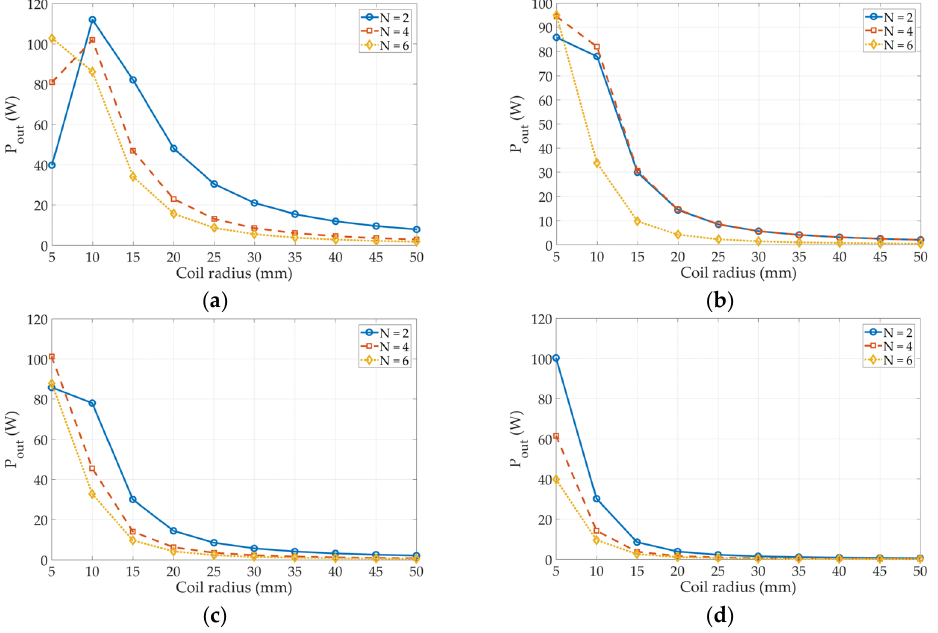
Figure 12. Comparison of output powers at various coil radii and numbers of turns for ( a ) S–S, ( b ) S–CCL, ( c ) CCL–S, and ( d ) CCL–CCL topologies.